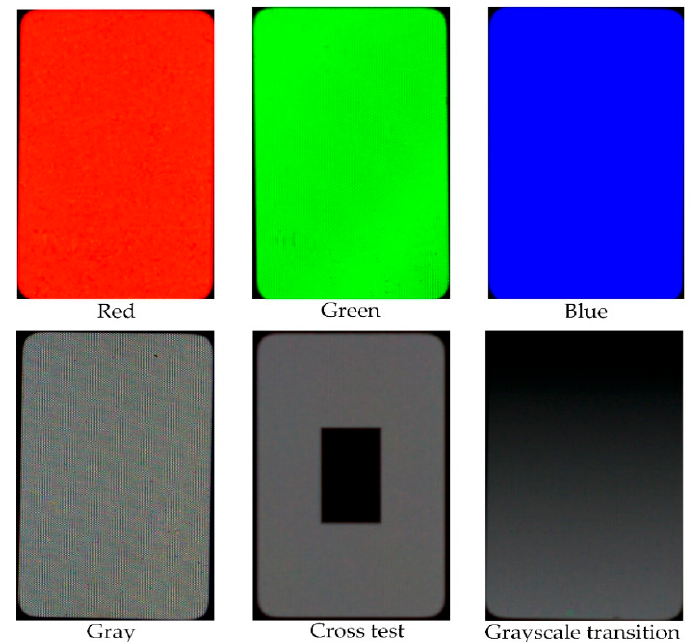
Figure 3. Defect-free test screen image.